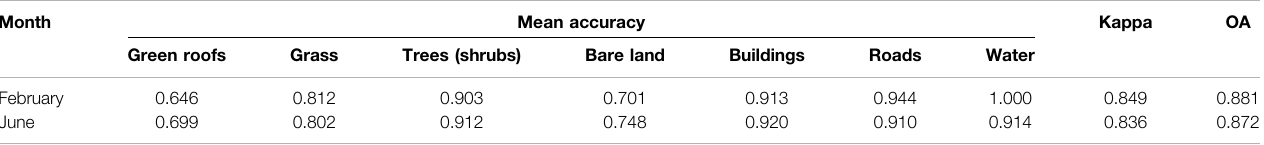
TABLE 5 | Comparison of classi fi cation accuracy for February and June.